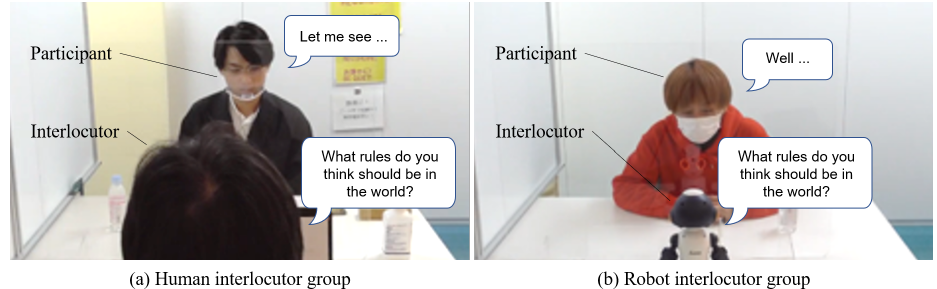
Figure 1. Experimental scenes of the human interlocutor group ( a ) and the robot interlocutor group ( b